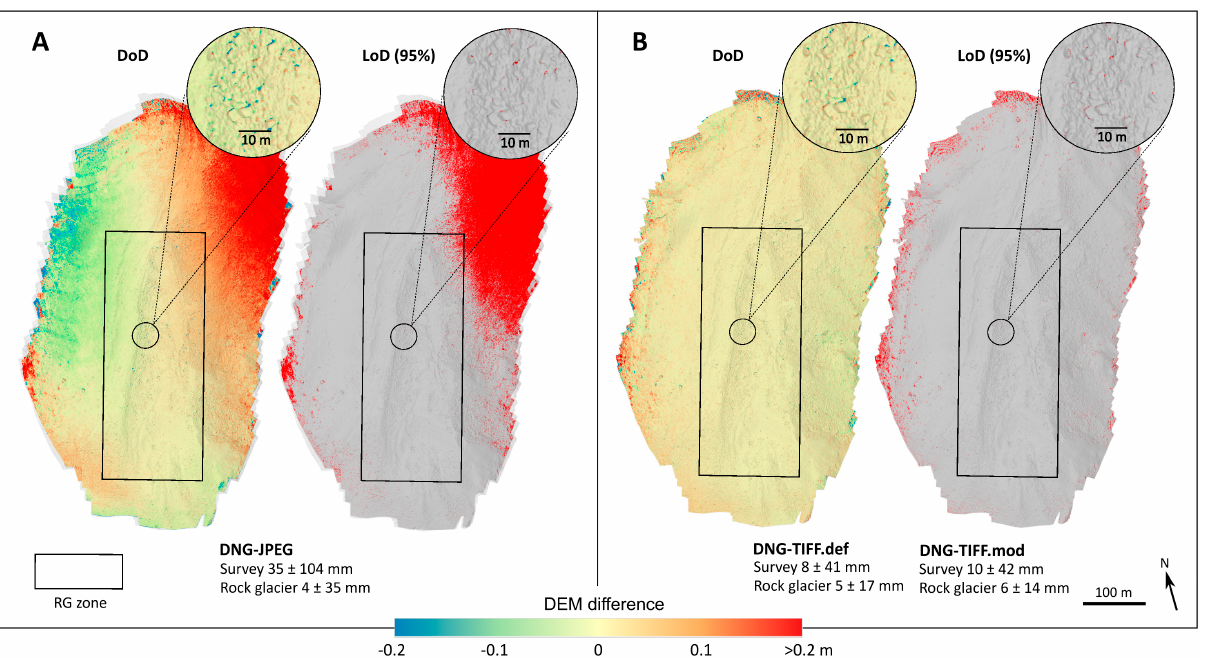
Figure 9. DEM of difference (DoD) distances and significant change identification. Mean and standard deviation values of the entire survey and RG zone are shown (all the surveys were cropped according to the extent of the JPEG reconstruction). DoD distances equal or less than -0.2 m are shown in blue and distances equal or greater than 0.2 m are shown in red. DoD significant changes (LoD95%) are shown in red color. ( A ) DNG to JPEG DoD comparison. ( B ) DNG to TIFF.def and TIFF.mod DoD comparison. At the level of detail presented, there is no difference between TIFF.def and TIFF.mod; therefore, only one figure is shown. Table 6. Summary of 2.5D comparisons between the photogrammetric surveys of the different image sets in the areas studied. Mean and standard deviation of the differences are shown, as well as the percentage of pixels where the differences are significant (95% confidence level).